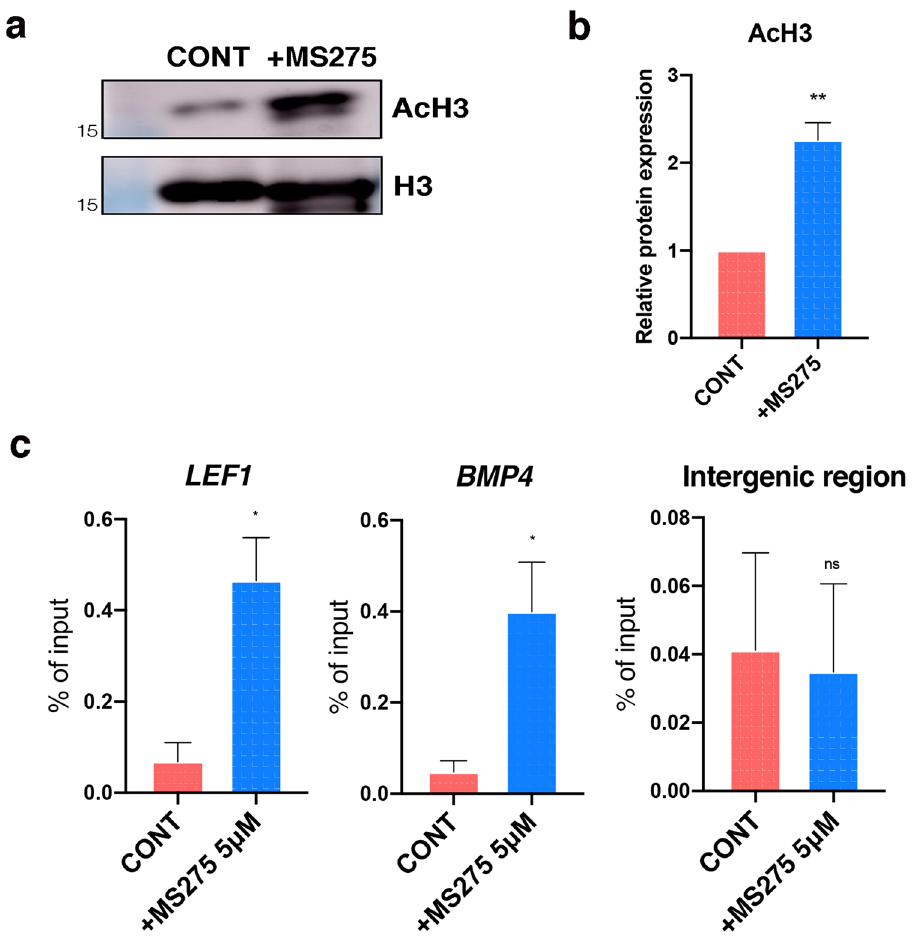
Figure 5. Histone H3 acetylation at the promoter regions of LEF1 and BMP4. ( a ) Histone H3 acetylation in MS275 treated DCs compared to CONT DCs. ( b ) The expression level of Histone H3 acetylation quantified by AMERSHAM imagequant software. Data were shown as the mean ± S.E.M (n = 3) (**, P < 0.01). ( c ) ChIP-qPCR using acetylated H3 antibody against the promoter regions of LEF1 and BMP4 in control and treated DCs. An intergenic region primer was used as a negative control and samples were normalized against the input DNA and represented as % of input. Data are shown as the mean ± S.E.M (n = 3) (*, P < 0.05). CONT, controls; DCs, dermal